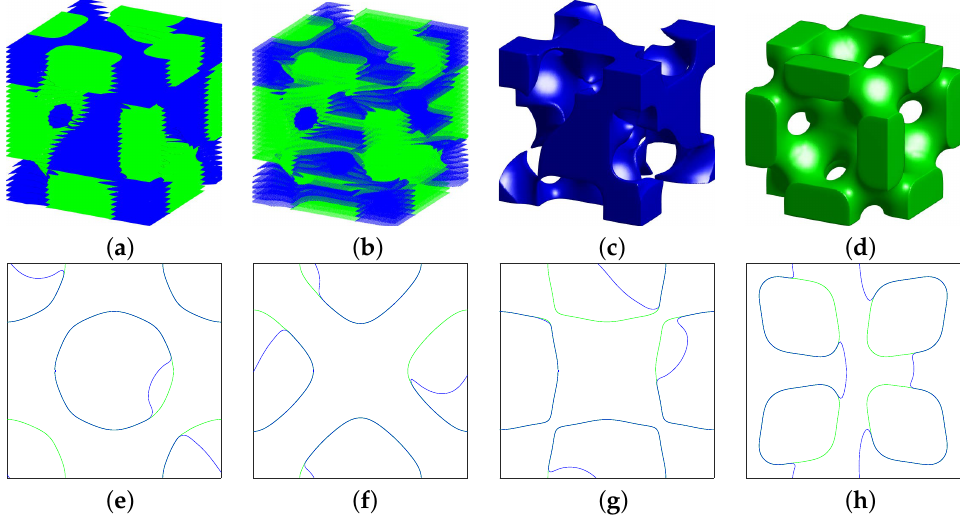
Figure 11. Comparisons with the related work [45]. ( a ) Given set of slice data. ( b ) Transformed point clouds. ( c ) Reconstructed Schwarz diamond minimal surface. ( d ) Reconstructed Schoen’s F-RD minimal surface. ( e – h ) Two-dimensional results at the slice data z = 20, 50, 80, and 110,